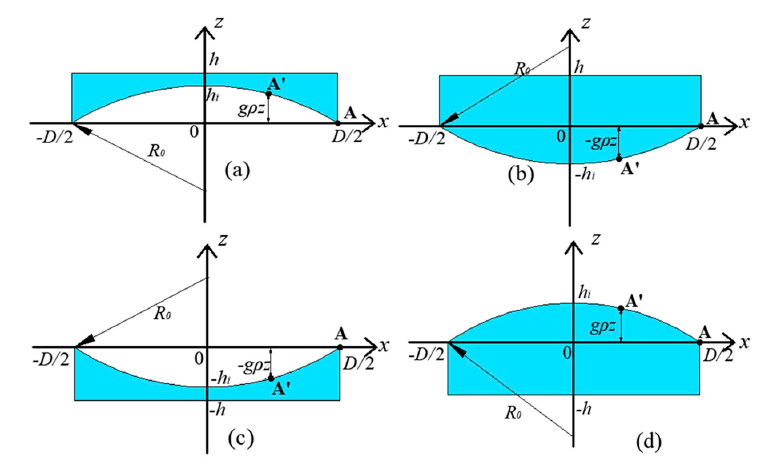
Figure 3. Deformation model, ( a ) concave LFS in the inverted state, ( b ) convex LFS in the inverted state, ( c ) concave LFS in the positive state, and ( d ) convex LFS in the positive state.